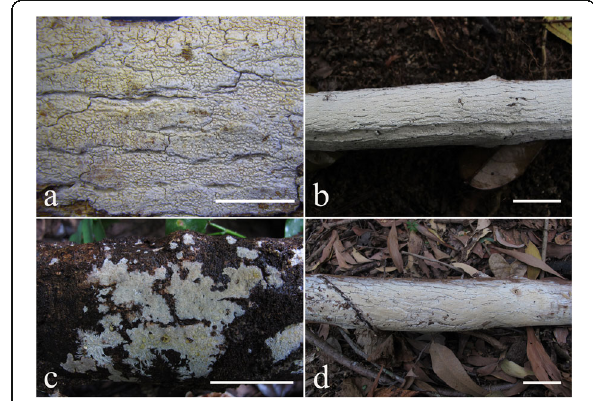
Fig. 4 Basidiomes of Resinicium austroasianum . a , b LWZ 20180417-5 (holotype). c LWZ 20171014-3 (paratype). d LWZ 20180518-2 (paratype). Scale bars: a = 5 mm, b – d = 2